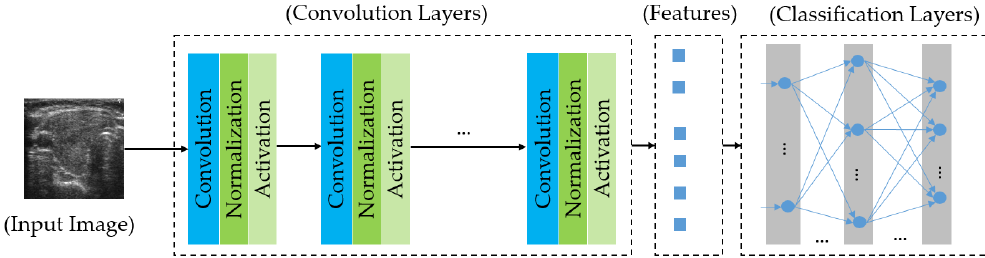
Figure 5. A general architecture of a Convolutional Neural Network (CNN) network for the image classification problem. classification